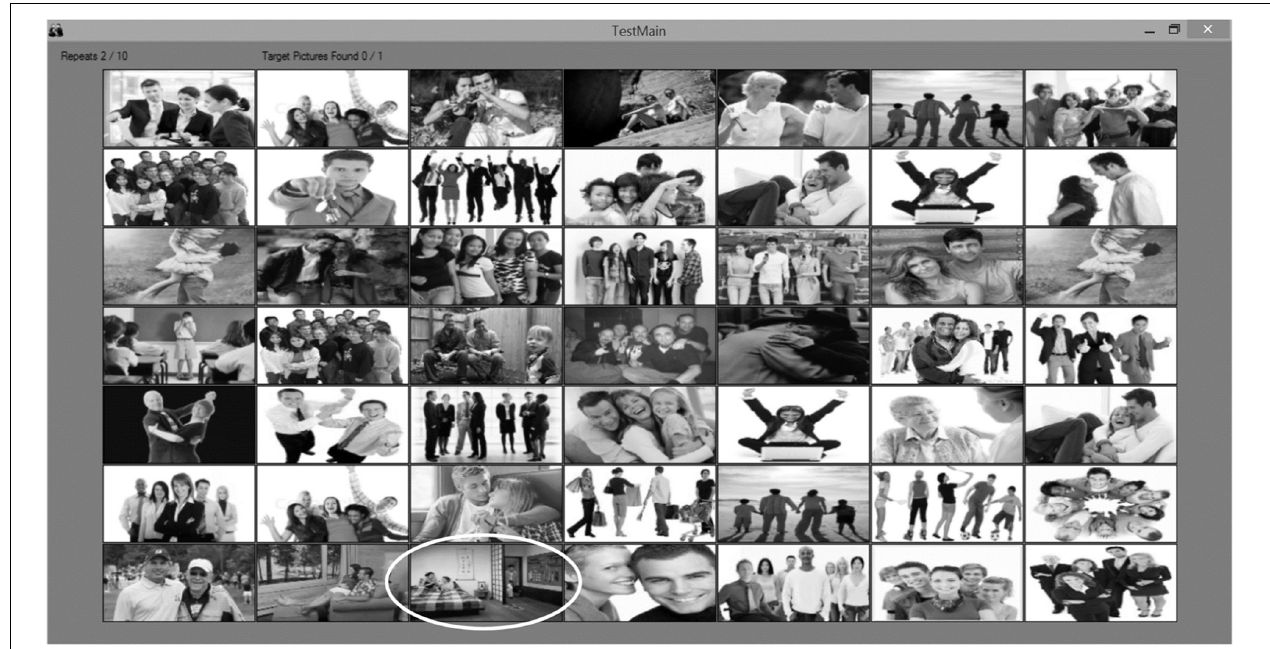
FIGURE 1 | Computerized infidelity detection task. Participants are instructed to click as quickly as possible with the left button of the mouse on the target picture, which portray signs of infidelity. An example of a target picture is marked by a white oval shape.